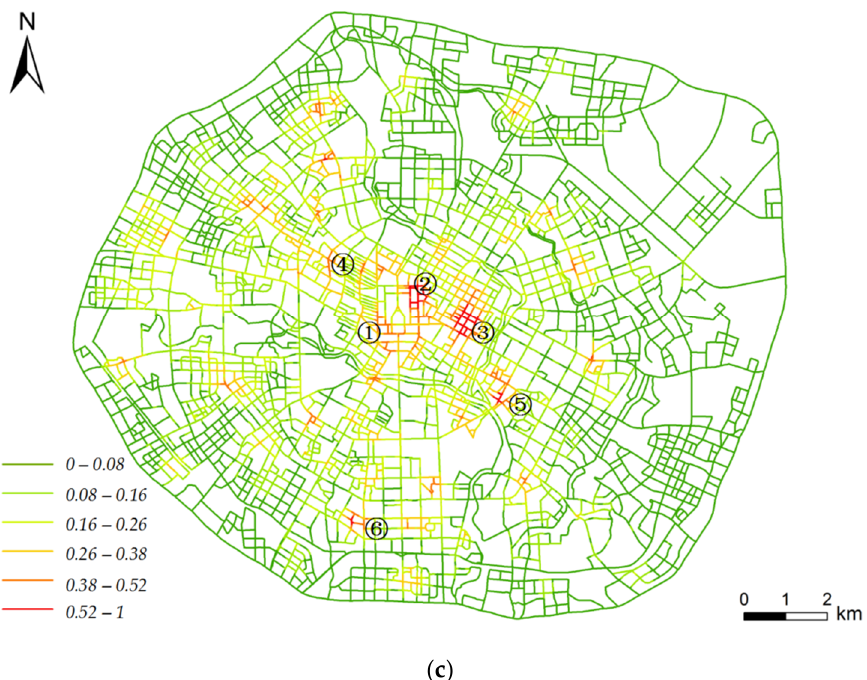
Figure 4. Spatial pattern of urban vitality on streets. The locations indicated by numbers (e.g., ① , ② , ③ …) in the graph are areas with high vitality values. ( a ) Social vitality. ( b ) Economic vitality. ( c ) Cultural vitality.